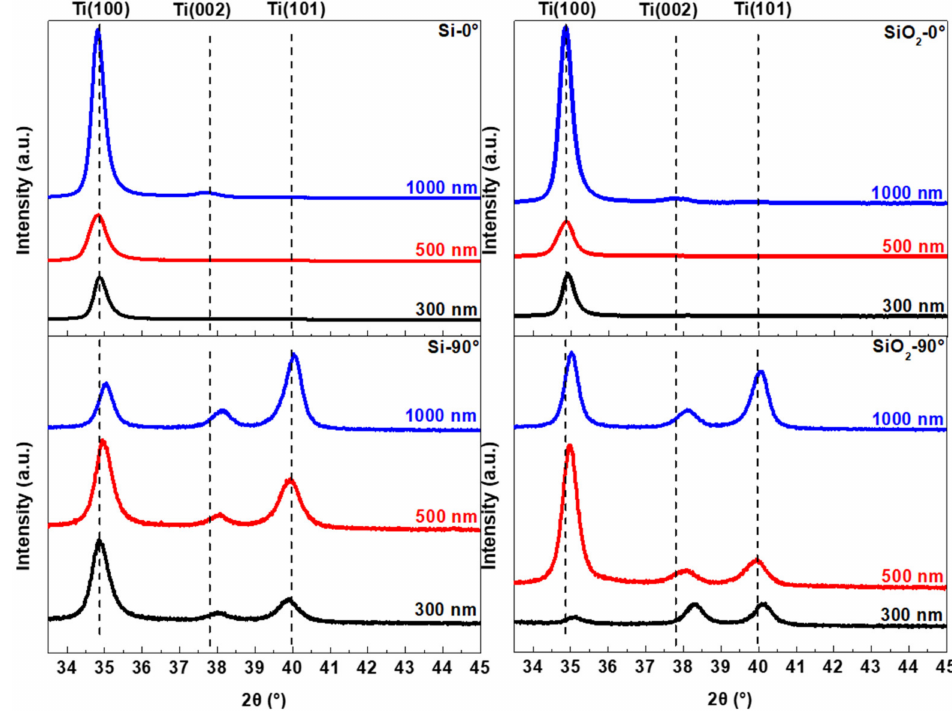
Figure 5. XRD patterns of Ti films deposited on Si and SiO 2 at 0 ◦ and 90 ◦ with different film thicknesses.